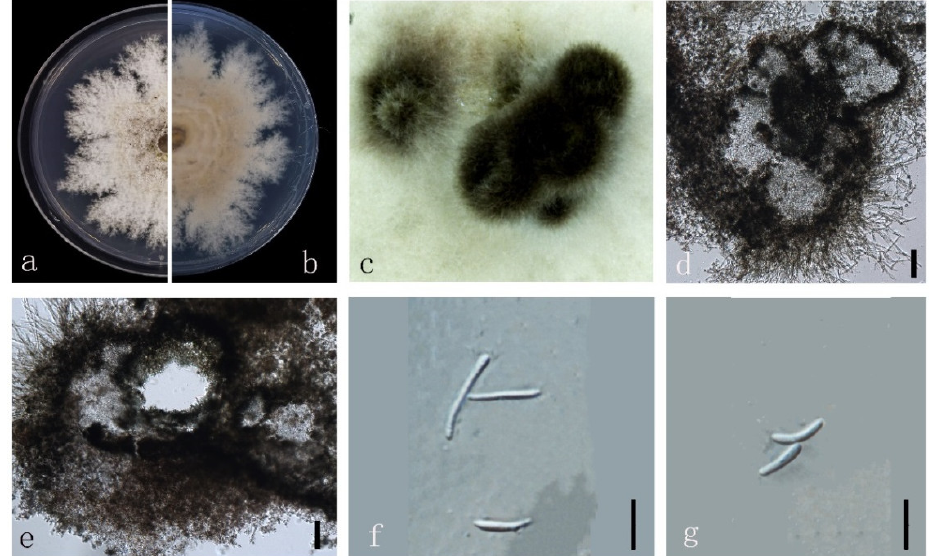
Figure 15. Diaporthe zhaoqingensis (ZHKUCC 22-0056) ( a ) upper view of colonies on PDA; ( b ) Re- verse view of colonies on PDA; ( c ) Pycnidia with conidial droplets on PDA; ( d , e ) Pycnidium; ( f – g